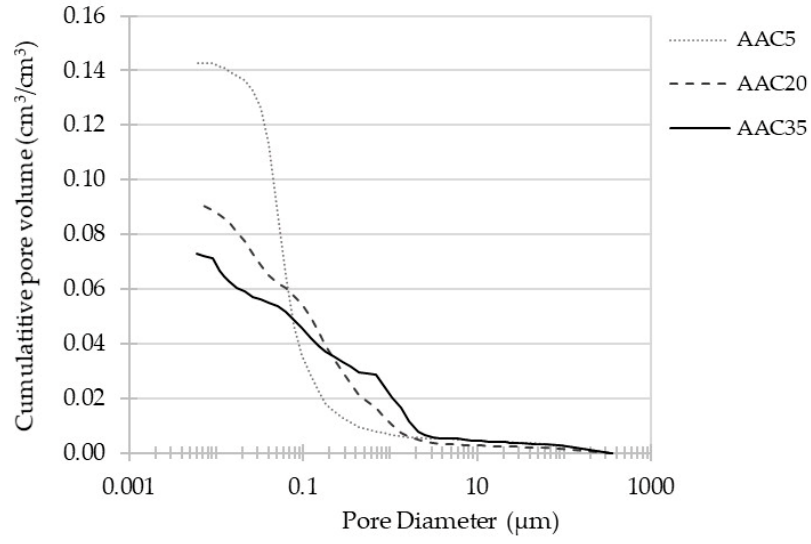
Figure 9. Total porosity of alkali-activated concretes.